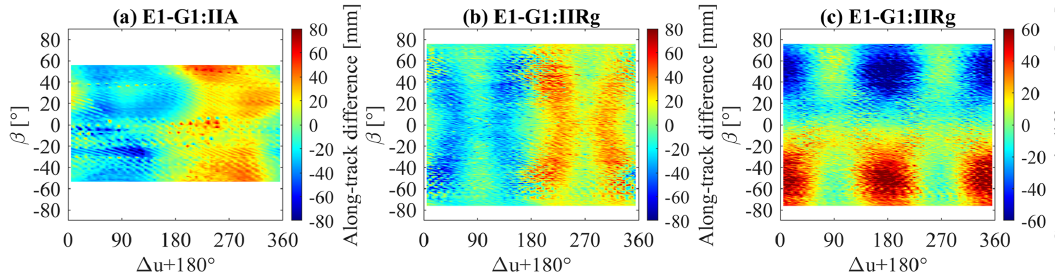
Figure 3. Selected orbit difference patterns in along-track (a, b) and cross-track (c) directions. Table 2. The RMS (unit: mm) and pattern types of orbit difference for the five compared pairs. RMS Pattern Block IIA Block IIR/IIR-M Block IIF Block IIA Block IIR/IIR-M Block